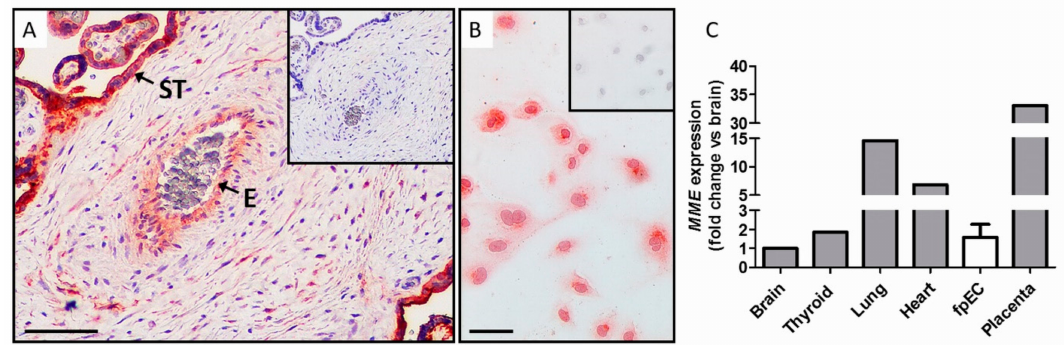
Figure 1. MME (membrane metalloendopeptidase) protein and mRNA expression in feto-placental endothelium. ( A ) In placental tissue, positive staining for MME (red) was detected in the syncytiotrophoblast (ST) facing the maternal circulation, as well as in the feto-placental endothelium (E) facing the fetal circulation. Nuclei were stained blue with DAPI (4 (cid:48) ,6-diamidino-2-phenylindole). Scale bar: 100 µ m. ( B ) Immunocytochemistry revealed that isolated primary feto-placental endothelial cells (fpEC) continued to express MME in culture. Scale bar: 200 µ m. Negative controls using unspecific mouse IgG are shown in the inserts. ( C ) Comparison of MME mRNA expression in different classical MME-producing tissues and organs, and in fpEC and placenta. Data were normalized to the mean of the house-keeping genes hypoxanthine-guanine phosphoribosyltransferase ( HPRT1 ) and peptidylprolyl isomerase A ( PPIA ) and represented in relation to the expression in brain.